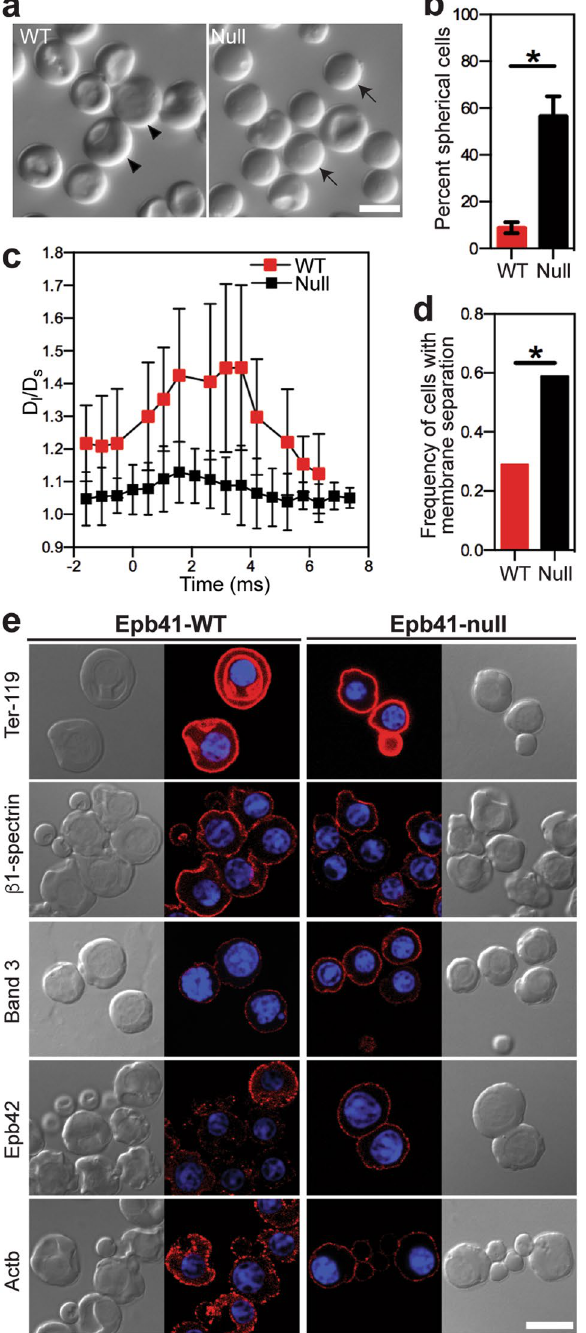
Figure 5. Epb41 -null primitive erythroblasts at the OrthoE stage (E12.5) have abnormal cell shape and defects in physical membrane features. ( a ) Morphology of freshly isolated Epb41 -wild-type (WT) and Epb41 - null primitive erythroblasts at E12.5. Spherical cells, arrows; partially concave cells, arrow heads. ( b ) The percentage of spherical cells at E12.5. Numbers represent at least 300 total cells per sample and error bars are SEM of three independent samples per stage. * p = 0.0028. ( c ) Aspect ratio (D l /D s ) changes of deforming E12.5 Epb41 -WT and Epb41 -null primitive erythroid cells in the microfluidic channel. D l , cell length; D s , cell width. Time 0 indicates the time when cells enter the constriction channel. ( d ) AlexaFluor 488-Ter119 labeled E12.5 Epb41 -WT and Epb41 -null primitive erythroblasts were analyzed using fluorescence imaged deformation (FIMD). A significantly higher frequency of Epb41 -null primitive OrthoE display evidence of membrane separation. * p = 0.0212. ( e ) Immunofluorescence of cytoskeletal proteins (red) in Epb41 -WT and Epb41 -null E12.5 primitive erythroblasts. Nuclei were stained with Hoechst (HO). Scale bar represents 10 µ